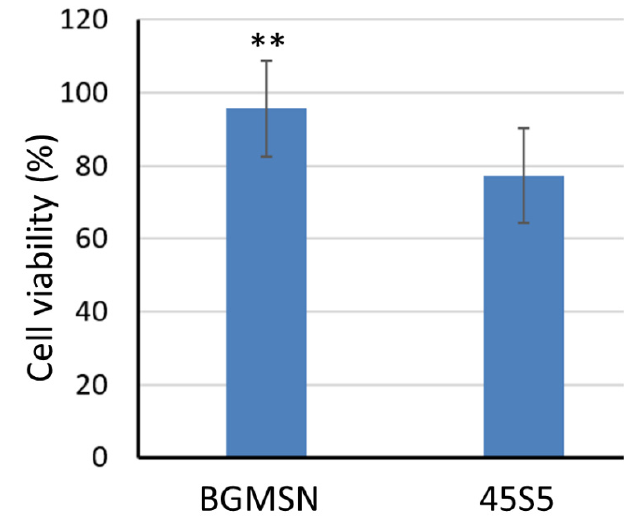
Figure 8. MTT test 24 h after culturing MLO-Y4 cells in contact with samples’ eluates. ** p < 0.05.